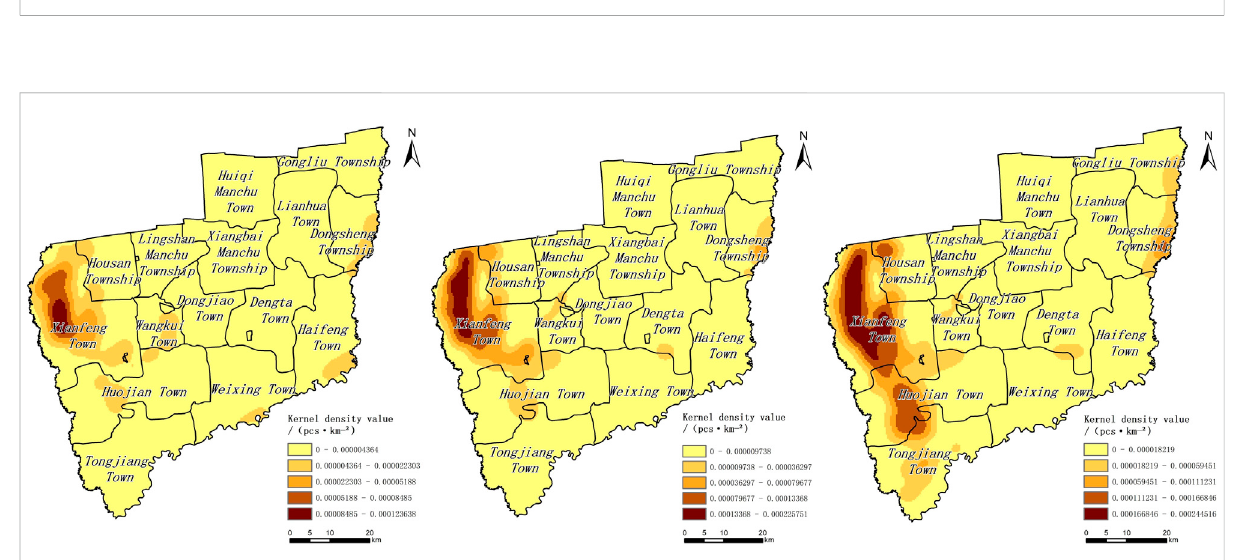
FIGURE 8 Spatial distribution characteristics and evolution of maize continuous-cropping pattern.